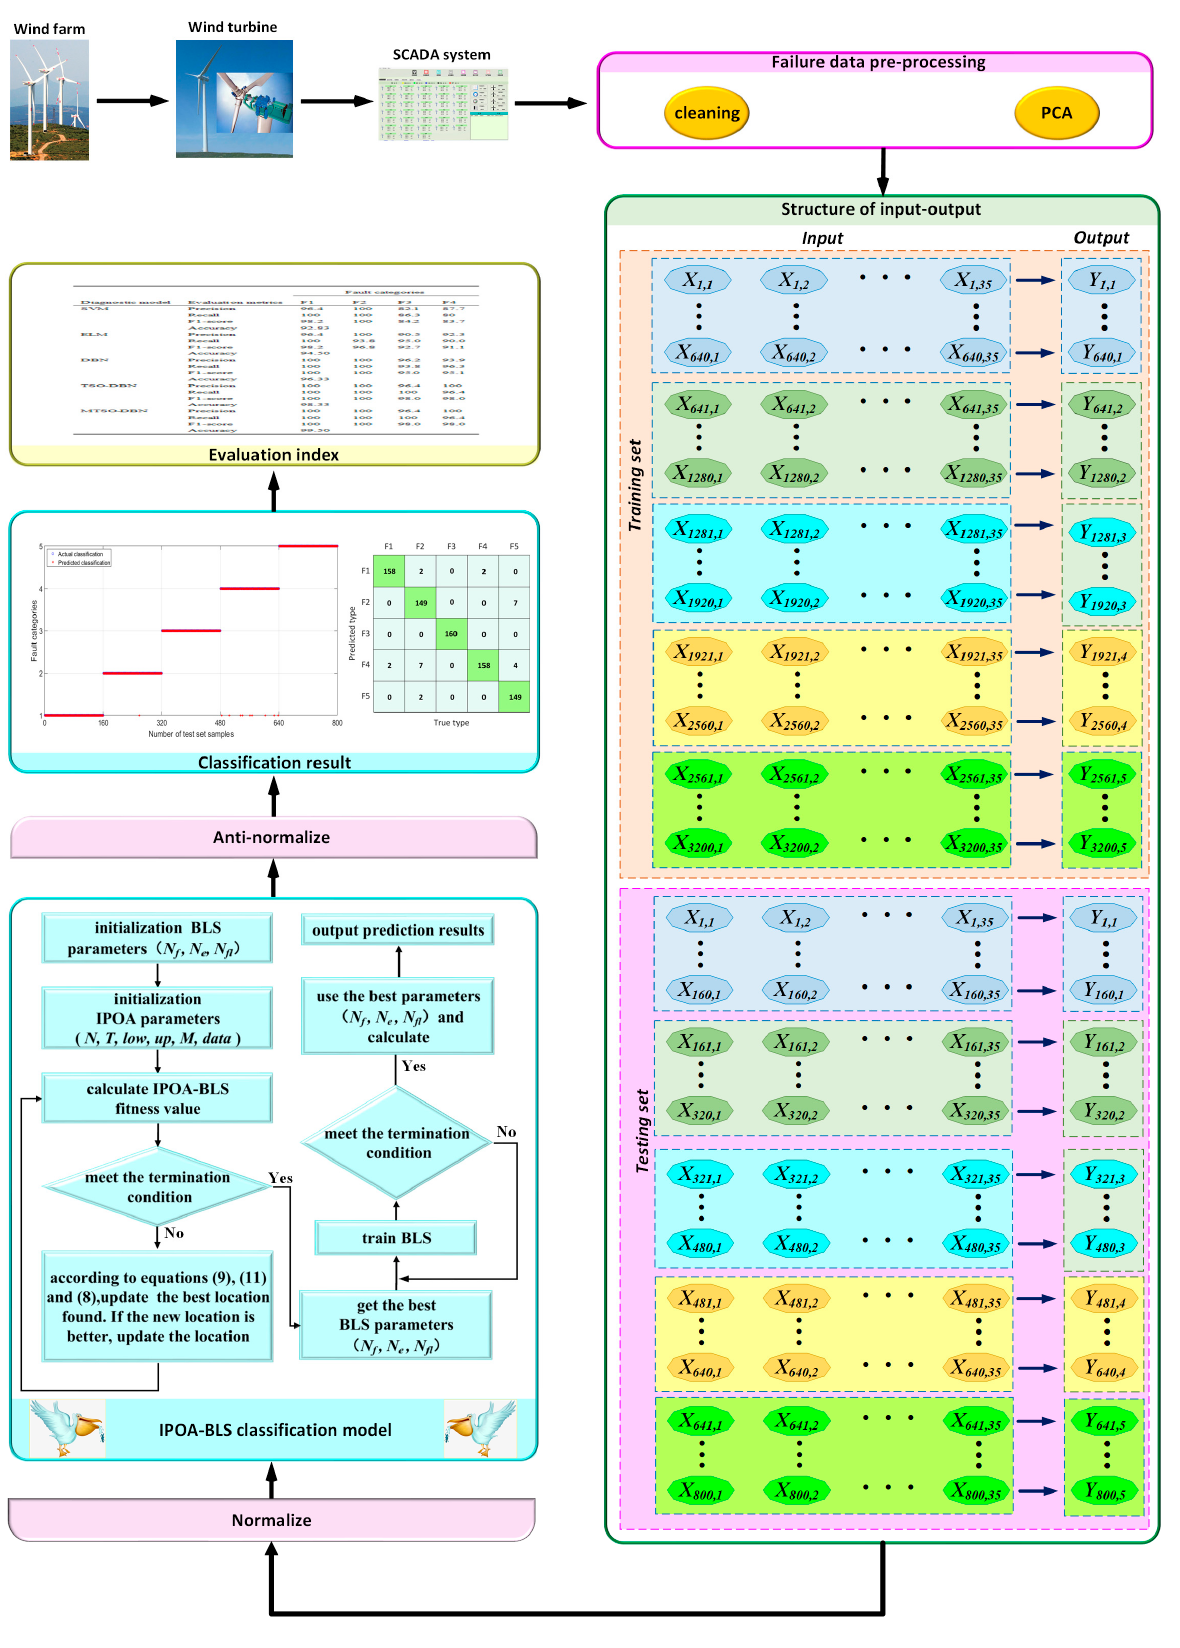
Figure 5. Classification process of the IPOA-BLS model.